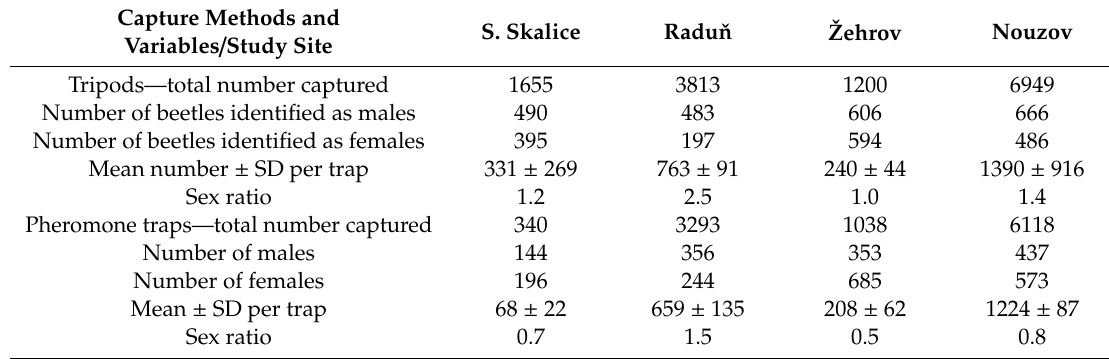
Table 7. Numbers of I. cembrae captured by pheromone traps and tripods in experiment 4. Capture Methods